Question: What visual encoding does this figure use to show its data?
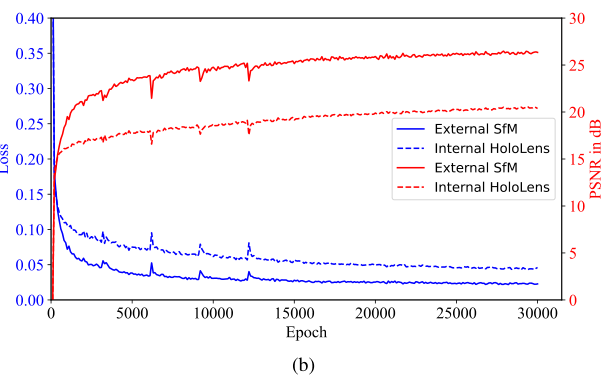
Answer: line